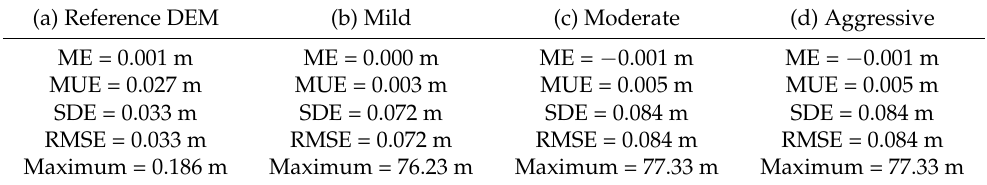
Figure 5. Evaluation of image alignment accuracy setting during sparse DEM reconstruction showing vertical errors at 177 RTK-GNSS survey points for ( a ) low, ( b ) medium, ( c , d ) high and ( e ) highest alignment accuracy setting. For all scenarios tested, “source” reference pair preselection was used, except for panel ( d ). Photogrammetric targets used as GCPs and ChkPts are shown as triangles and circles, respectively. Error evaluation was performed using 1 m resolution DEMs. Table 7. Evaluation of depth filtering during dense DEM reconstruction at La Palue field site. Except for the reference DEM using no depth filtering, for which errors are estimated in comparison to 1381 RTK-GNSS survey points, vertical error statistics are the result of intercomparing DEMs with the reference DEM. All DEMs evaluated were reconstructed using “High” image alignment accuracy (Figure 5c) and “High” reconstruction quality for sparse and dense DEM reconstructions, respectively (cf. explanations in the text). Evaluations were performed using 0.1 m resolution